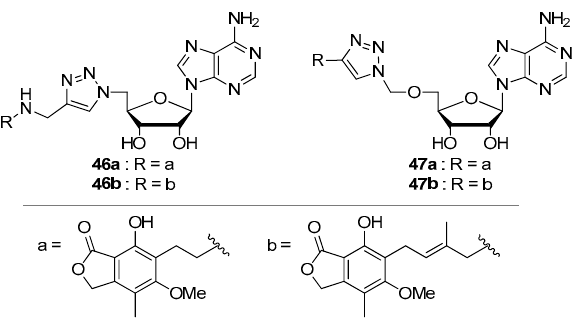
Figure 10. Triazol containing NAD + analogs synthesized as potent inhibitors 46 – 47